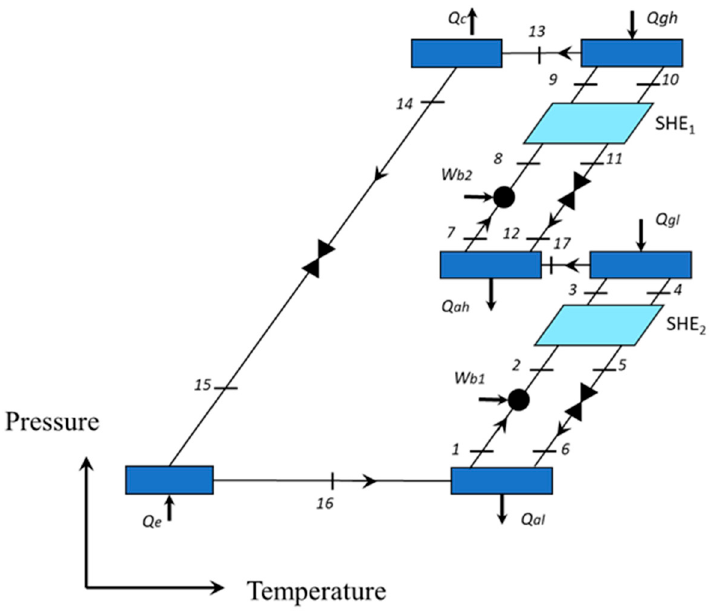
Figure 2. Schematic diagram of a half-effect absorption cooling system.